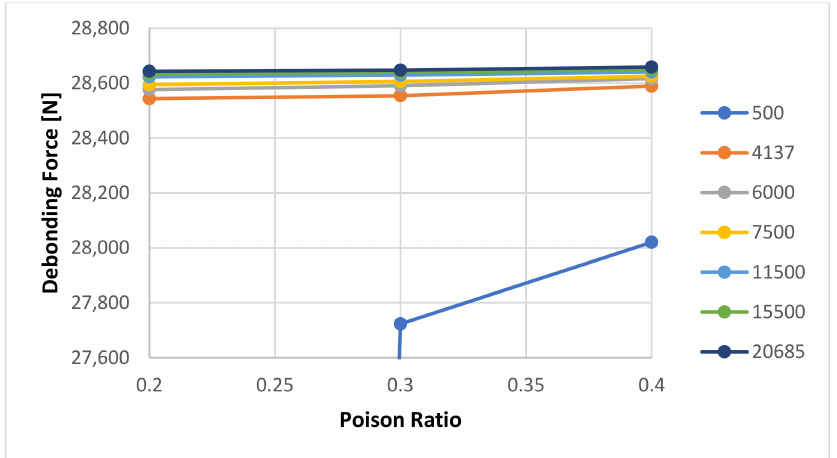
Figure 19. Detailed view of the calculated debonding force as a function of Poisson Ratio and selected Young’s Modulus of the cement with a 7-day curing